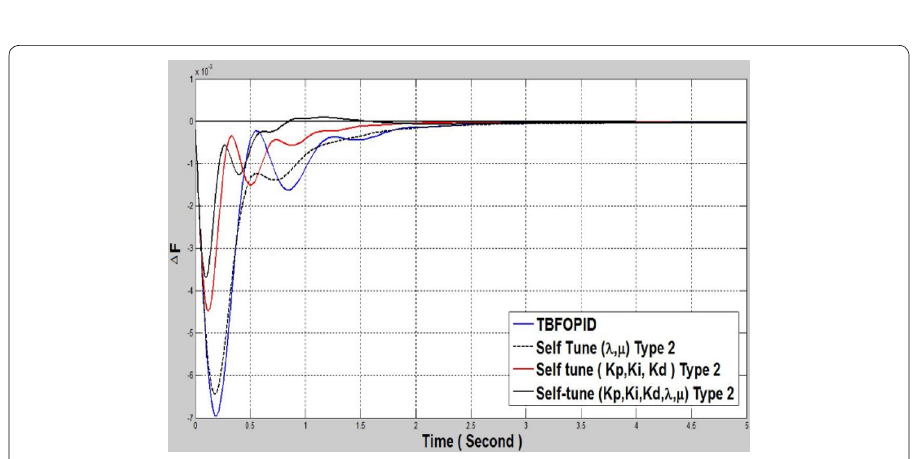
Fig. 26 Response of Δ F via IT2FST ( k p , k i , k d , λ and μ